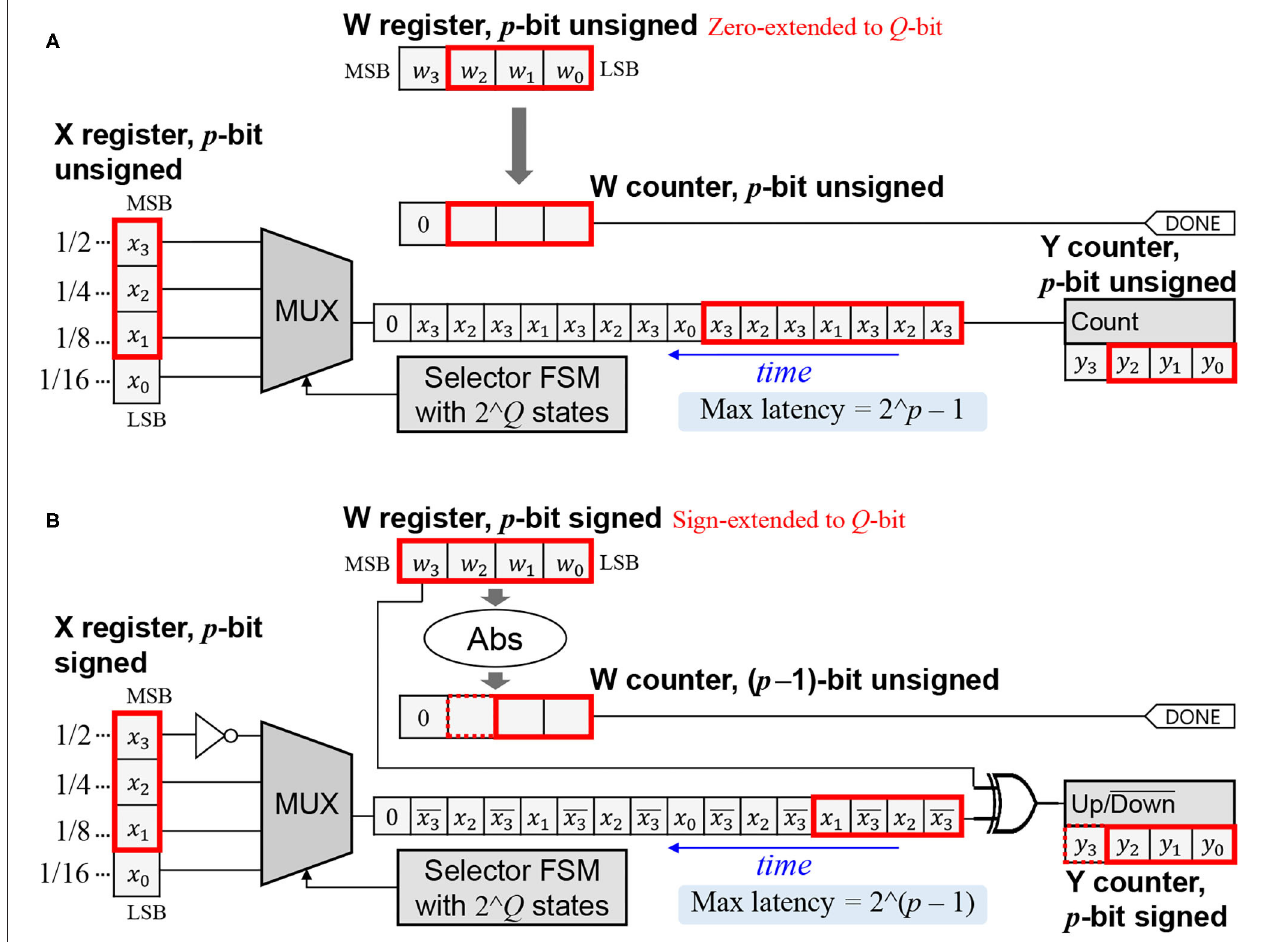
FIGURE 2 | SC-MAC from Sim and Lee (2017) extended for dynamic precision. Datapath remains the same; only the control is changed ( p : dynamic precision, Q : the maximum supported precision). (A) Unsigned version. (B) Signed version.